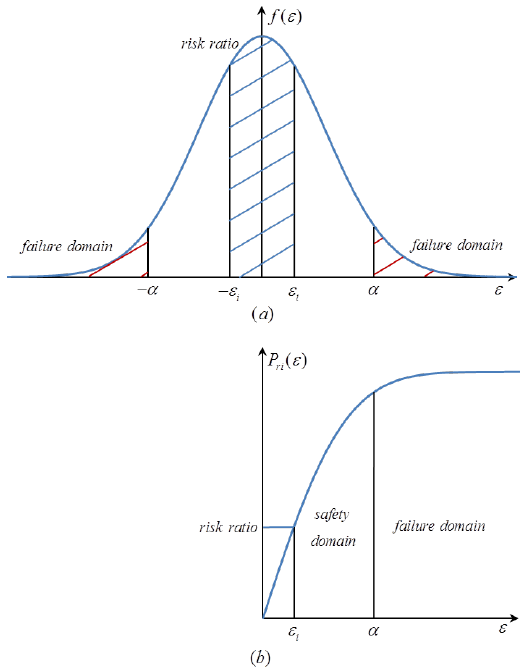
Figure 2. The relationship between the risk ratio P and the absolute residual | ε | : ( a ) the probability density function of | ε | , ( b ) the risk ratio function based on | ε |